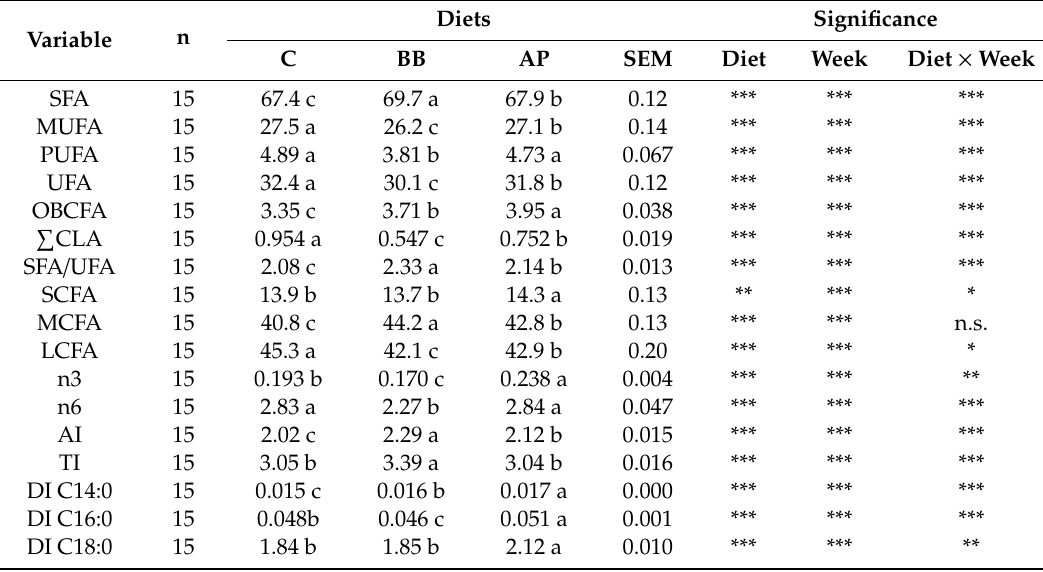
Table 6. Comparison of grouped fatty acids (g / 100 g total fatty acids), indices related to cardiovascular health and desaturation activity in goat milk from refrigerated tank according to the e ff ects considered from 7th to 27th lactation